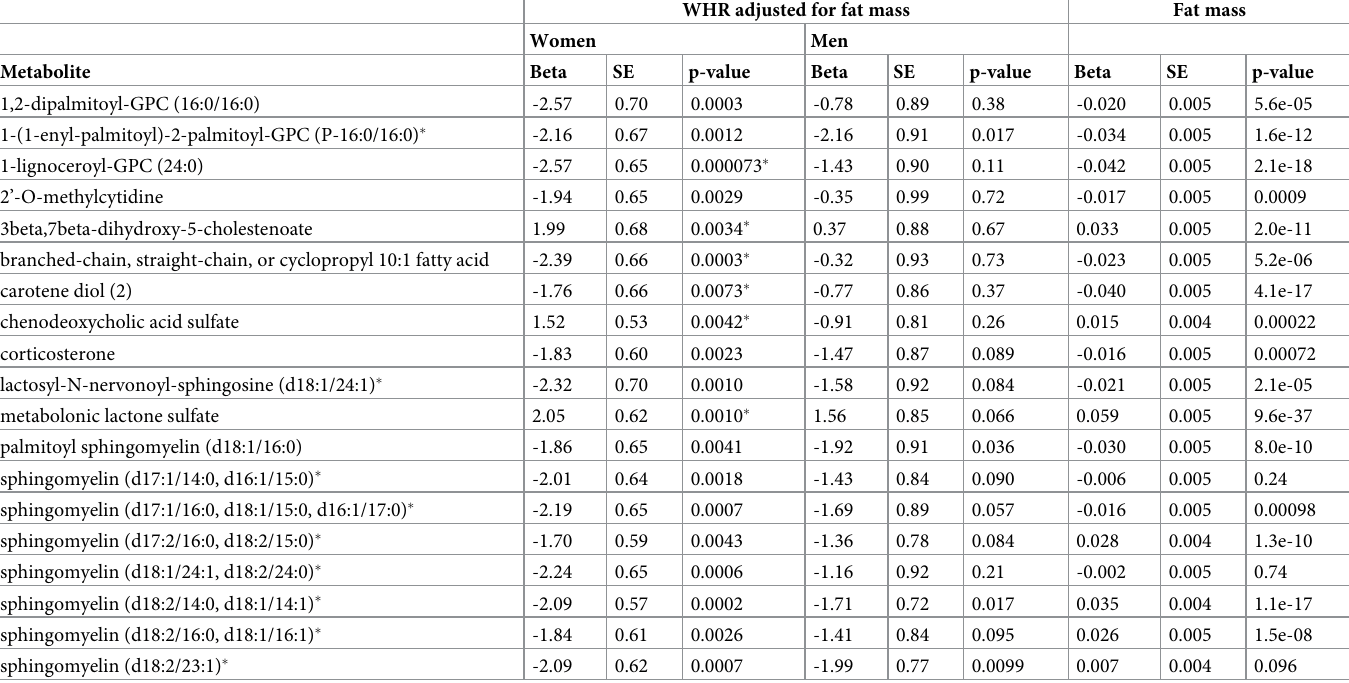
Table 2. Relationships between mass spectrometry-based metabolites and waist-hip ratio adjusted for fat mass (WHRadjfatmass) in males and females and vs fat mass in both sexes combined. WHR adjusted for fat mass Fat mass Women Men Metabolite